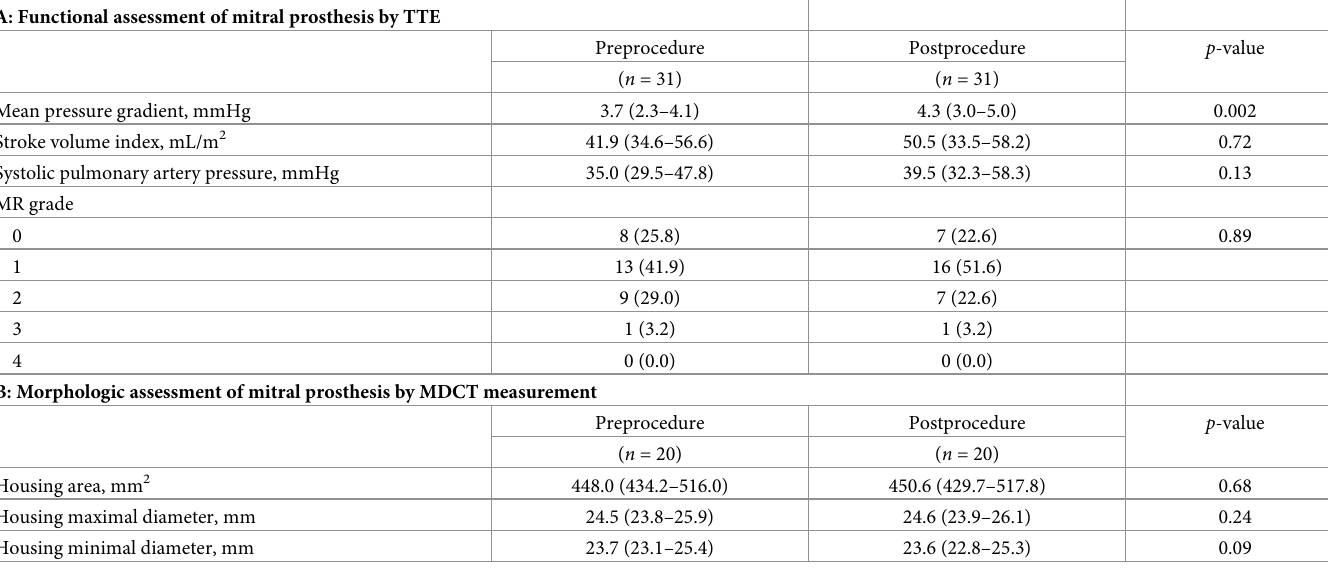
Table 4. Pre- and postprocedural mitral prosthesis function and